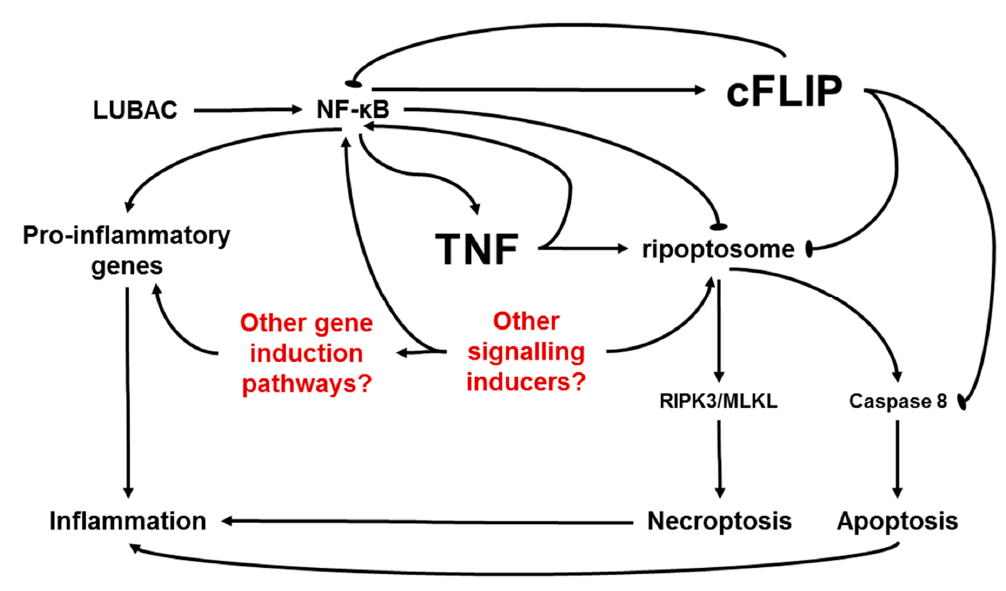
Figure 5. Suggested mechanism of NF- κ B-mediated cell death and inflammatory signaling in keratinocytes with dysregulated homeostasis. The LUBAC is required for NF- κ B activation